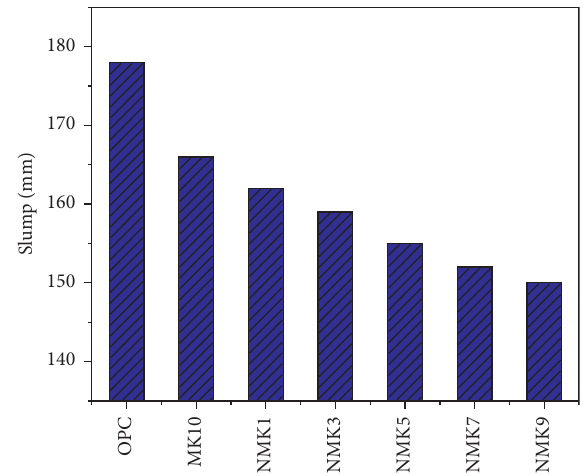
Figure 9: Effect of NMK content on the slump of UHPC [41].